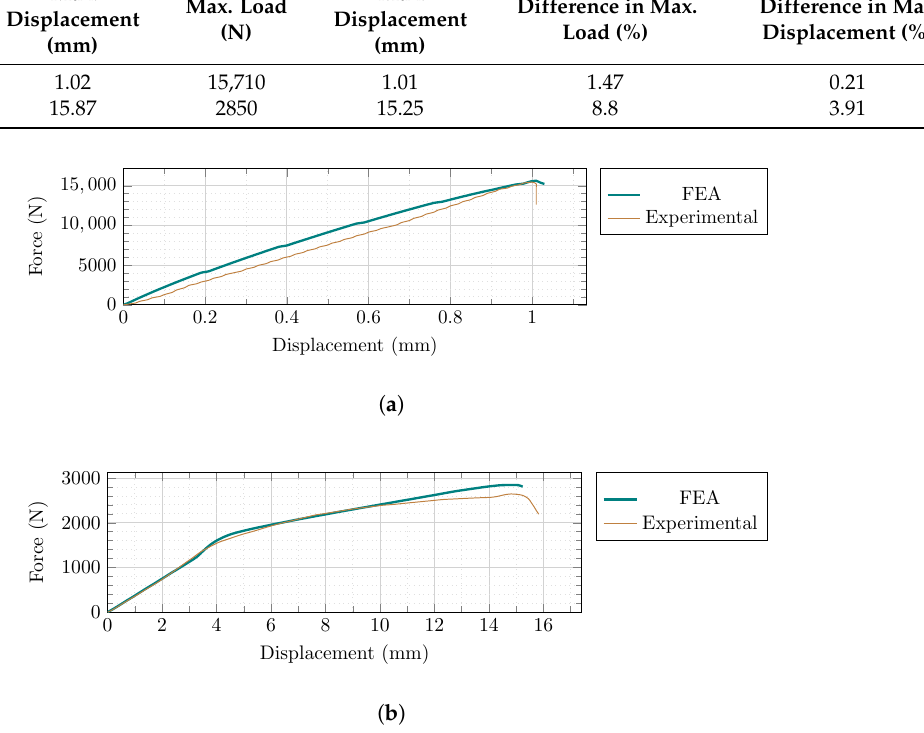
Figure 9. Comparison between the finite element analysis and the experimental results; ( a ) masonry prism; ( b ) ECC sheets.